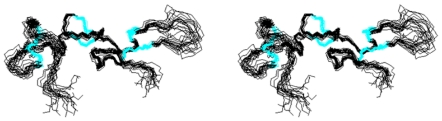
Structures of Rho P48A mutant.Stereo views of the 20 lowest-energy NMR structures of the Rho P48A mutant.